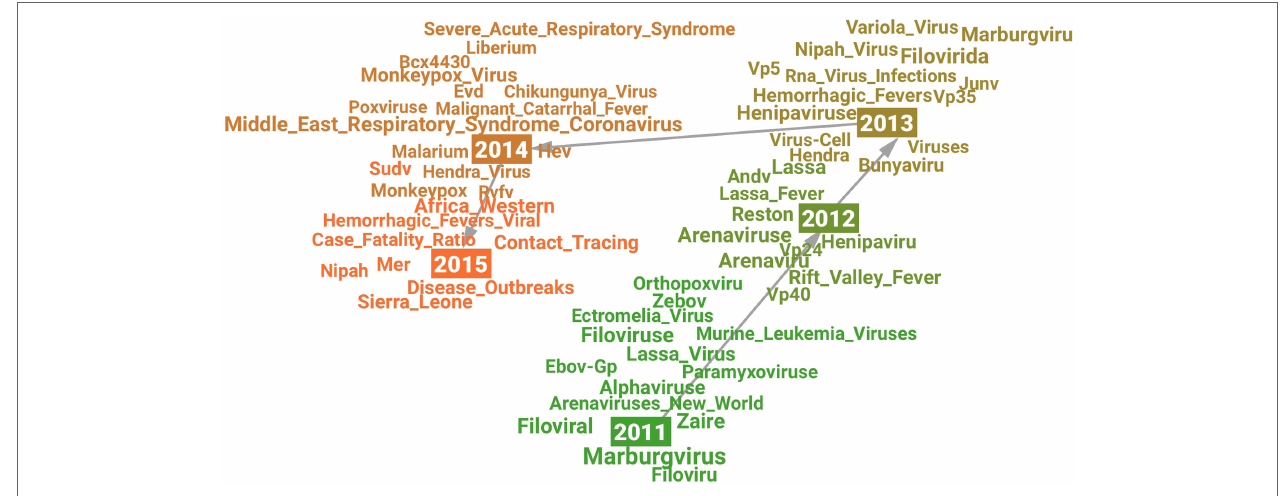
FIGURE 2 | Visualization of the semantic change in research on “Ebola Virus” from 2011 (green) to 2015 (orange).